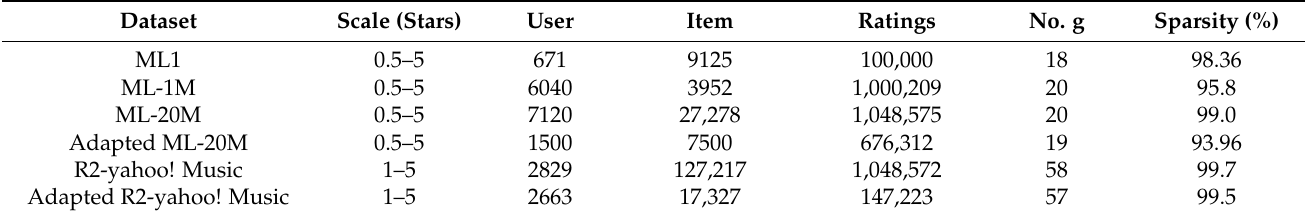
Table 4. Data sets